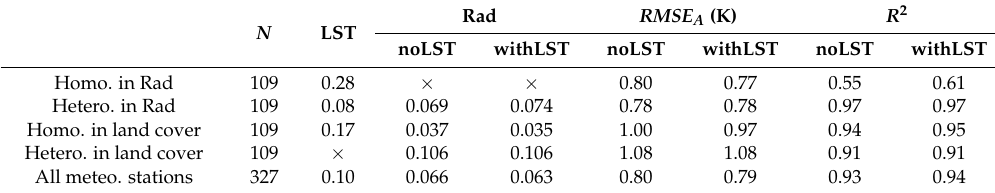
Table 5. Selected model characteristics and performance metrics by considering the meteorological stations classified into two sets (homogeneous and heterogeneous) and regarding their surrounding potential solar radiation (Rad) or land cover attributes. The case analyzed corresponds to the maximum T air observed during March 2014, including or not the LST provided by the daytime MYD11B3 product as an independent variable in the model. LST and Rad denote the standardized regression coefficients, × meaning non-significant ( p > 0.05). N : number of meteorological stations considered. Rad RMSE A (K) R 2 N LST noLST withLST noLST withLST noLST withLST Homo. in Rad 109 0.28 × × 0.80 0.77 0.55 0.61 Hetero. in Rad 0.08 0.069 0.074 0.78 0.97 0.97 Homo. in land cover 0.17 0.037 0.035 0.97 0.94 0.95 Hetero. in land cover 109 × 0.106 0.106